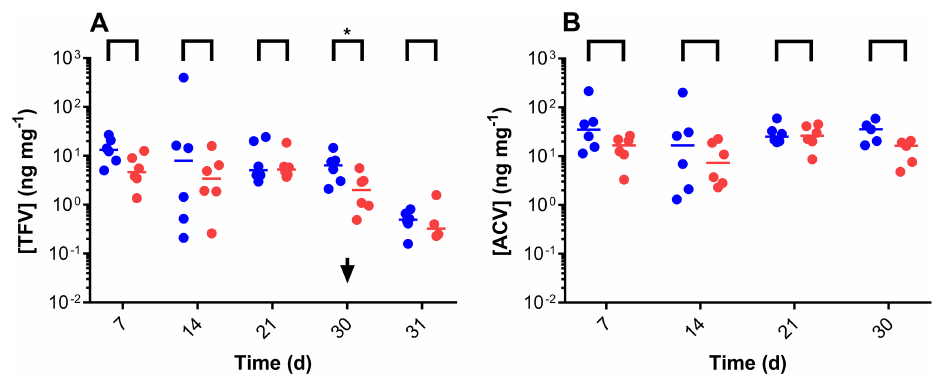
Fig 5. In vivo ( N = 6) vaginal fluid drug levels from Configuration A (Day 7, Day 14) and Configuration B (Day 21, Day 30) TAF 2 -ACV-ENG-EE pod-IVRs. Blue, proximal to the IVR; red, distal to the IVR; each circle correspondsto an individualdatum; horizontallines correspondto medians.(A) TFV (TAF hydrolysis product)vaginalfluid concentrations. The arrow (Day 30) correspondsto the time of Configuration B IVR removal. Paired proximal and distal vaginalfluid TFV concentrations at each timepointwere comparedusing Wilcoxon matched-pairs signedrank test: Day 7, P = 0.1563; Day 14, P = 0.5625; Day 21, P > 0.9999; Day 30, P = 0.0313 (significantly different); Day 31 (washout), P = 0.8750. (B) ACV vaginalfluid concentrations. Paired proximaland distal vaginalfluid ACV concentrations at each timepointwere compared using